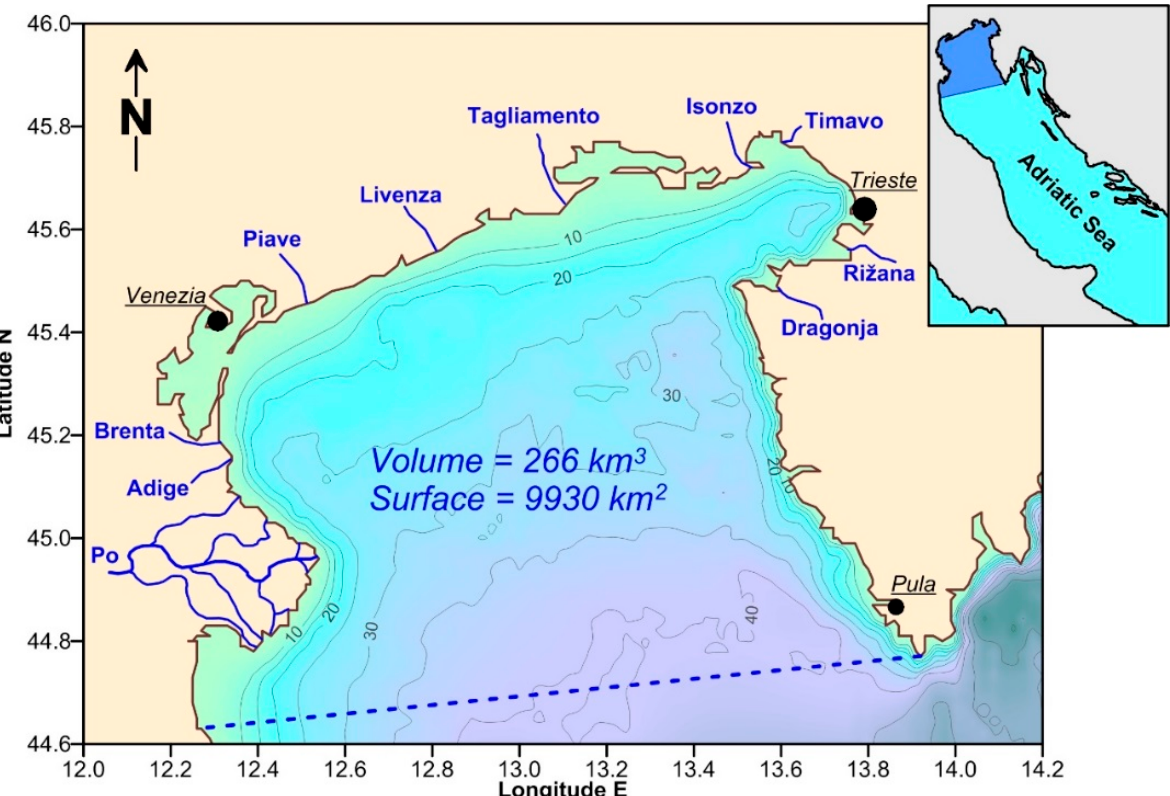
Figure 1. Northern Adriatic Sea (NAd) and the rivers (names in blue fonts) considered in the present study.